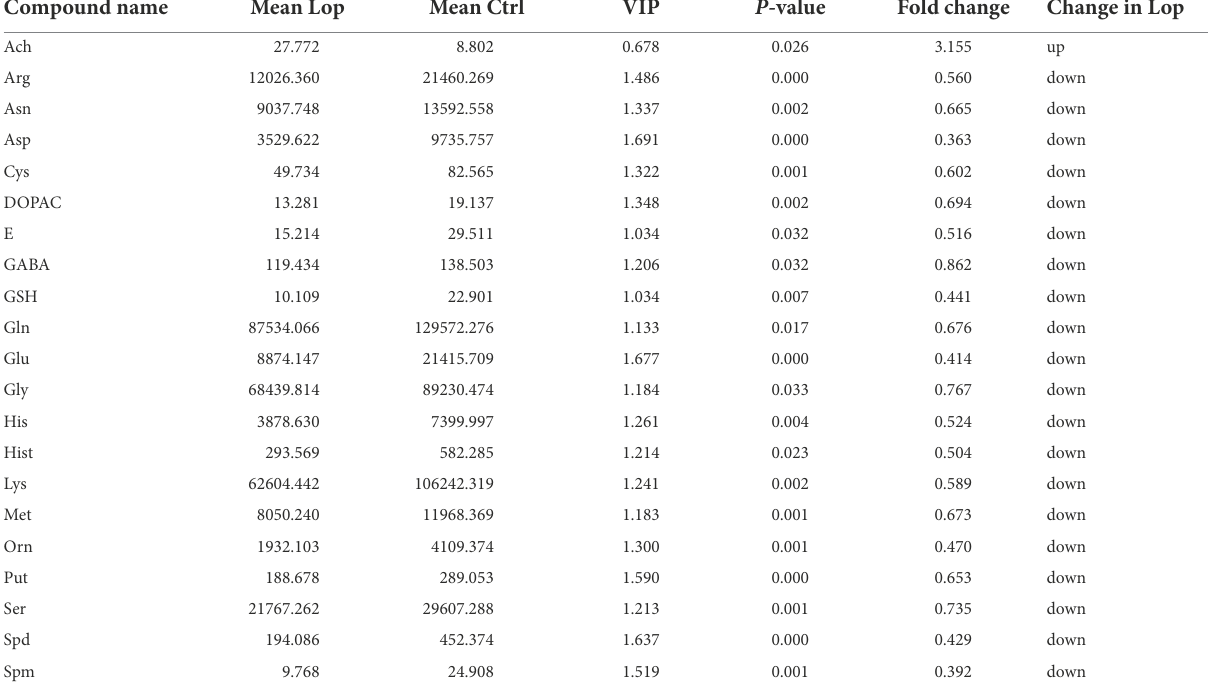
TABLE 1 Differential abundance of metabolites between the Ctrl and Lop groups.